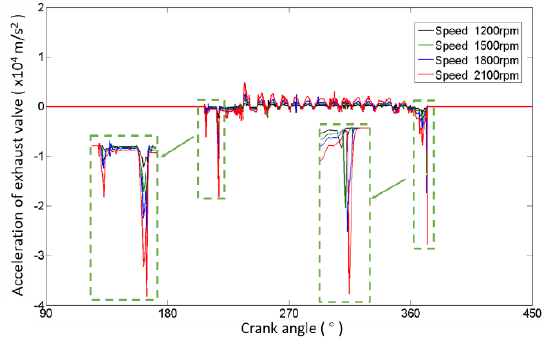
Figure 7. Valve acceleration of different clearances.